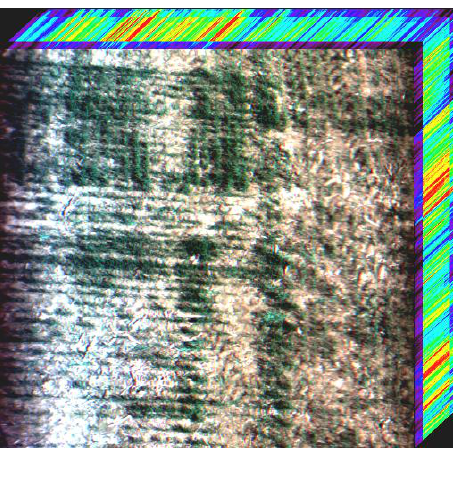
Figure 2. Vegetation image cube acquired by the FISS. The hyperspectral image was taken by FISS fixed in an elevated car, which was located 30 m above a wheat field in the Xiaotangshan National Demonstration Base for Precision Agriculture Research, Beijing, China.